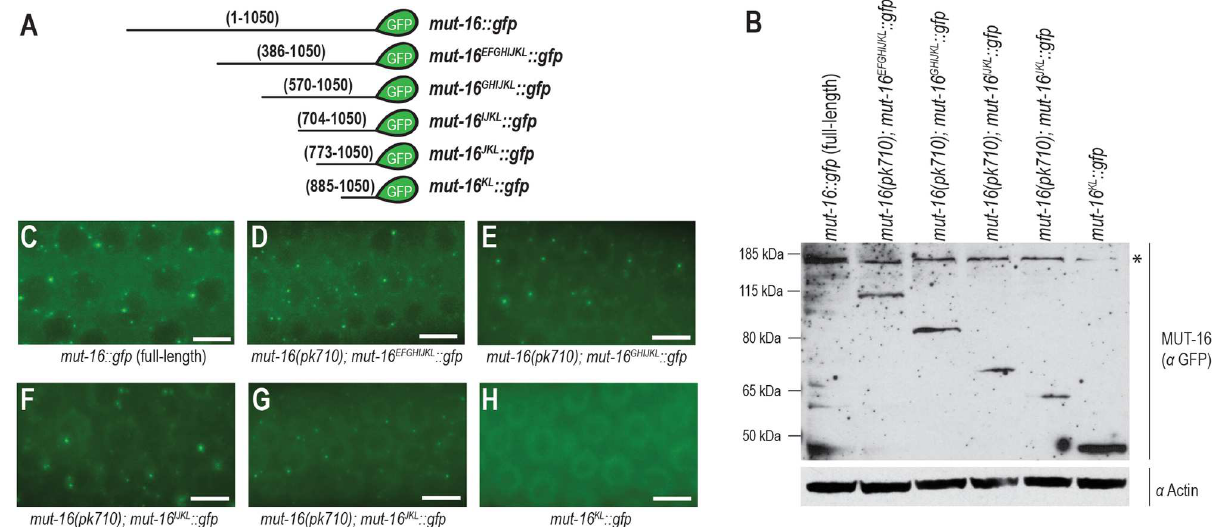
Fig 5. The C-terminal region of MUT-16 is sufficient for foci formation. (A) Diagram and amino acid coordinates of C-terminal regions of MUT-16 fused to GFP. (B) Western blot of full-length and C-terminal fragments of MUT-16::GFP probed with anti-GFP and anti-actin. A non-specific band (marked by asterisk) runs at a similar size to the full-length MUT-16::GFP. (C) Live imaging of full-length MUT-16::GFP, which forms foci throughout the germline. (D-G) C-terminal fragments of MUT-16::GFP form foci in the germline if they contain the minimal J, K, and L region (amino acids 773– 1050) of the protein, but the number and size of foci increase with larger protein fragments. (H) The KL region (amino acids 885–1050) of MUT-16 fused to GFP is not sufficient for foci anywhere in the germline. All images are from the transition zone (leptotene/zygotene) region of the germline. Scale bars, 5 μ